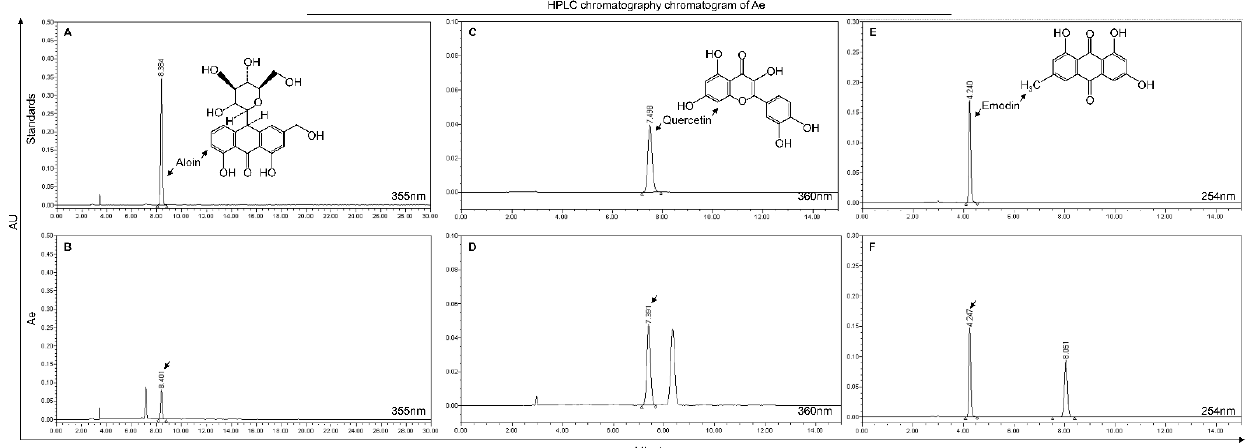
Figure 1. Ae inhibits PRRSV replication in vitro . ( A ) The cytotoxicity of Ae to Marc-145 and iPAM cells in vitro . Marc-145 or iPAM cells were cultured with various concentrations of Ae (2–8 mg/mL) or the control normal DMEM for 24 h and 48 h prior to the CCK-8 assay. ( B ) Marc-145 or iPAM cells were treated with various concentrations of Ae (1, 2 or 4 mg/mL) or the control normal DMEM for 1 h, followed infection with PRRSV at a MOI of 0.1. After 1 h, the cells were re-treated with Ae or DMEM as a control. At 24 h post-inoculation (hpi), an indirect immunofluorescence assay was performed. IFN- α was used as a positive control. CPE and PRRSV antigen were indicated by arrows. ( C ) Marc-145 or iPAM cells were treated as described above: at indicated time points (12 h and 24 h), cell lysates were prepared and examined with Western Blot using anti-PRRSV N monoclonal antibody and anti-GAPDH monoclonal antibody; or ( D ) the viral yield in the cell lysates were quantified by TCID 50 analysis. Results are representative of three independent experiments (mean ± SD). n = 8 or 3. ** p < 0.01, *** p < 0.001.